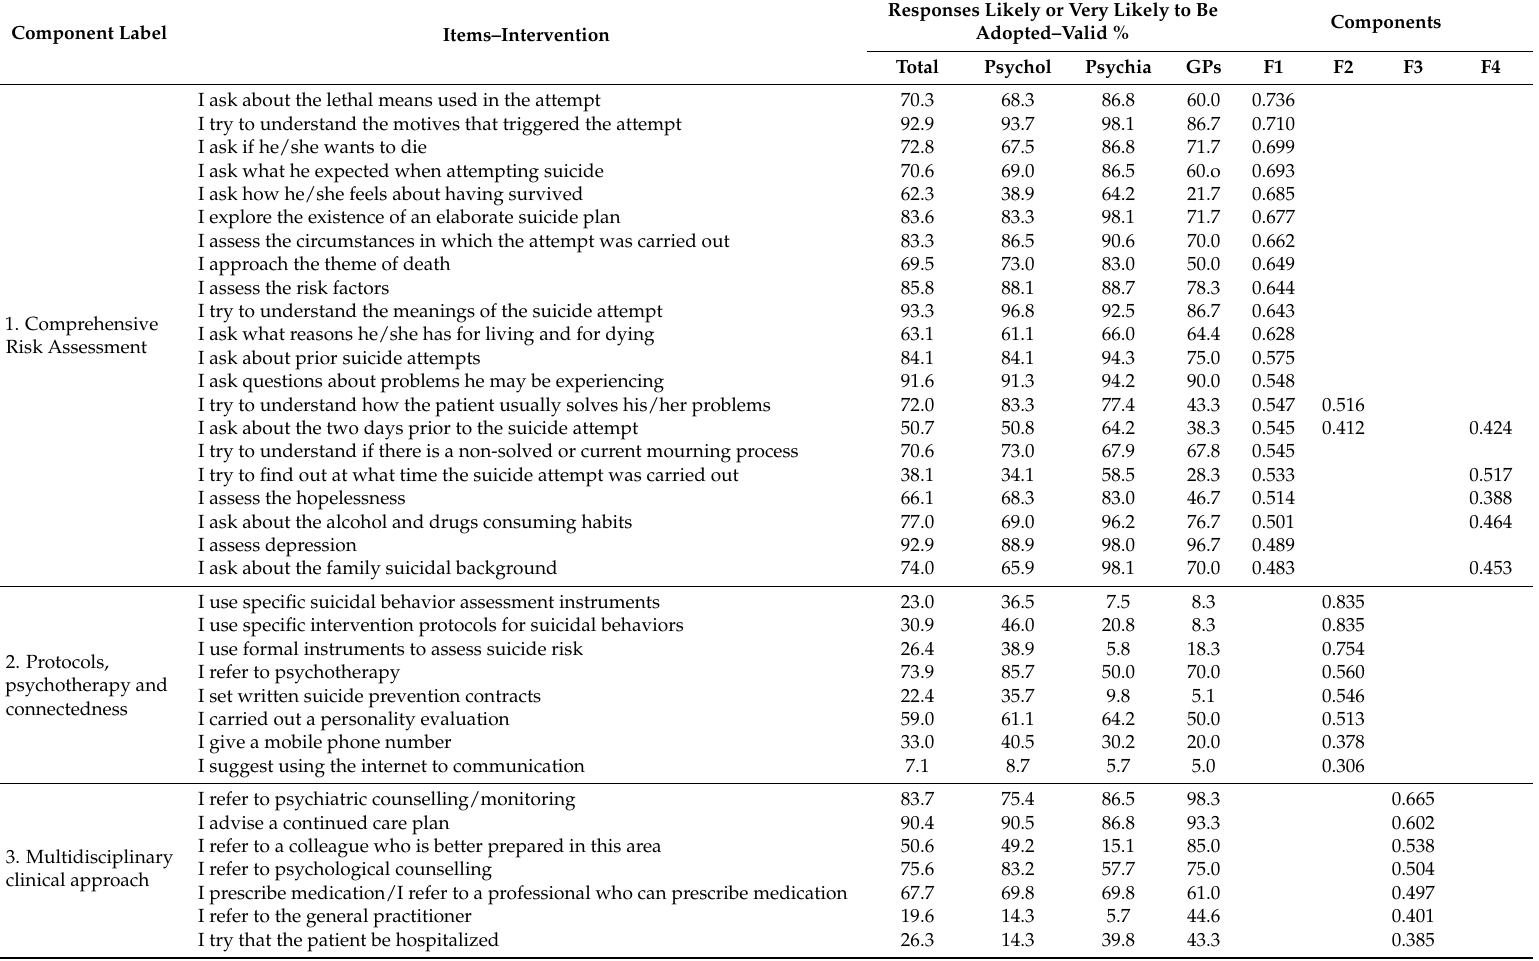
Table 2. Principal components of health professionals’ practices towards suicide